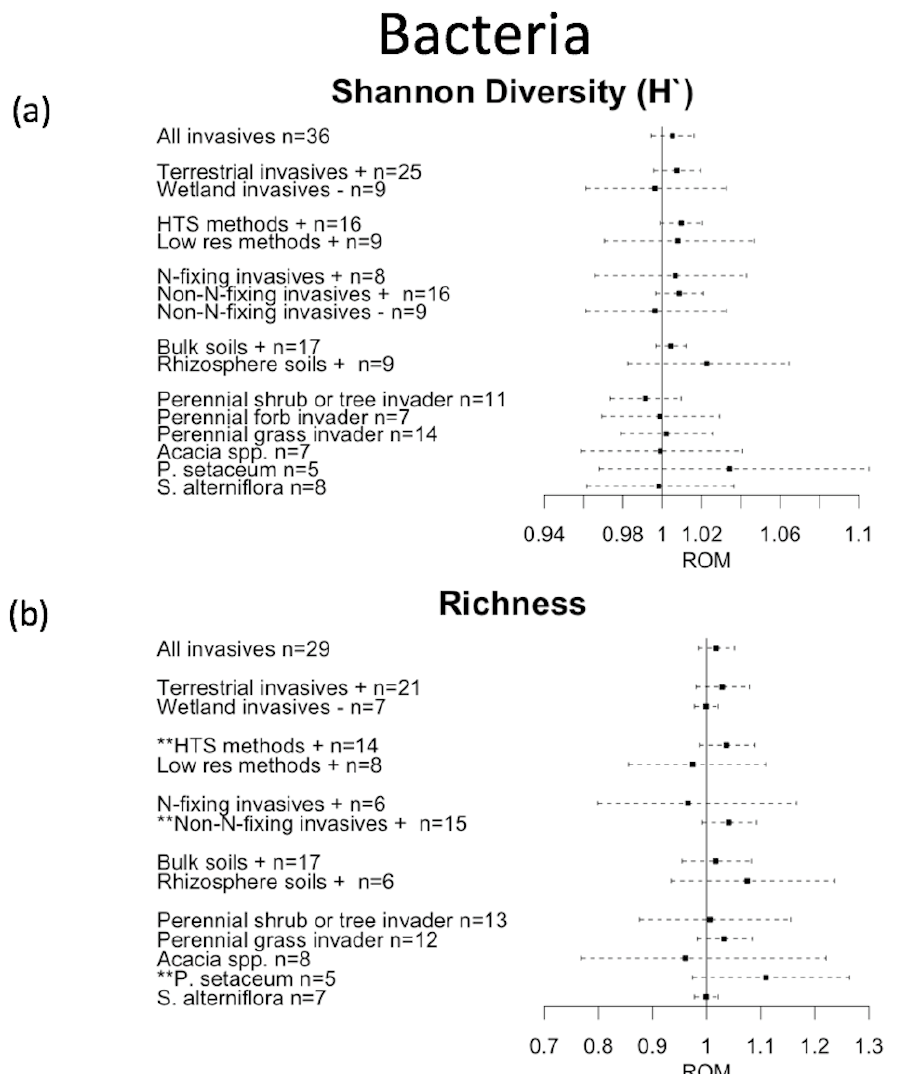
Figure 3. Forest plot of bacterial weighted response ratio (ROM) following invasion. ** indicates statistical significance in at least one model. The symbol “ + ” indicates only terrestrial studies were used in the calculation of the ROM, and “-” indicates only wetland studies were used. Additional information on which model produced statistical significance can be found in Supplementary Table S4. The most conservative model results are presented in this figure. The top line is all bacterial studies examined together. Plots are then sorted by subgroups. Labels include subgrouping and number of independent studies (n). Both panels follow the same formatting. ( a ) Weighted response ratio (ROM) of bacterial Shannon diversity (H‘); ( b ) Weighted response ratio (ROM) of bacterial richness.